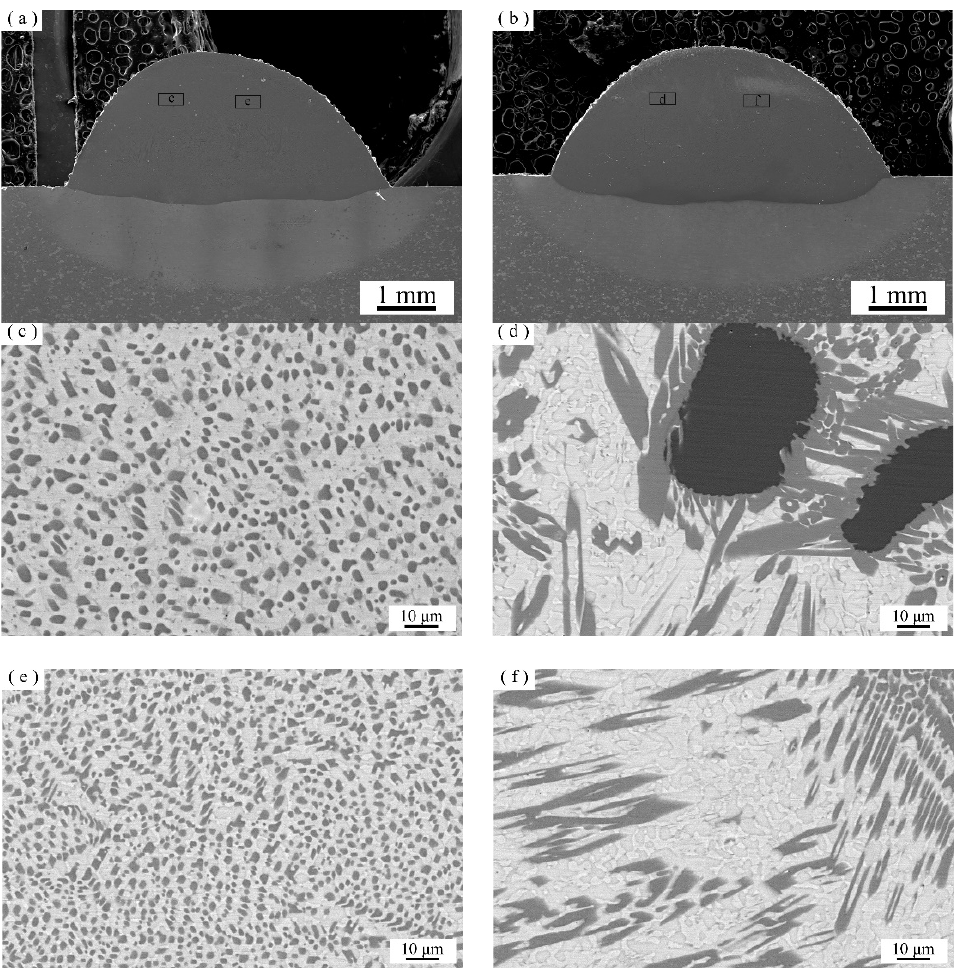
Figure 6. Macrostructure and microstructure morphologies of cladding layer cross section. ( a , c , e ) from the alloyed powder cladding layer; ( b , d , f ) from the mixed powder cladding layer.